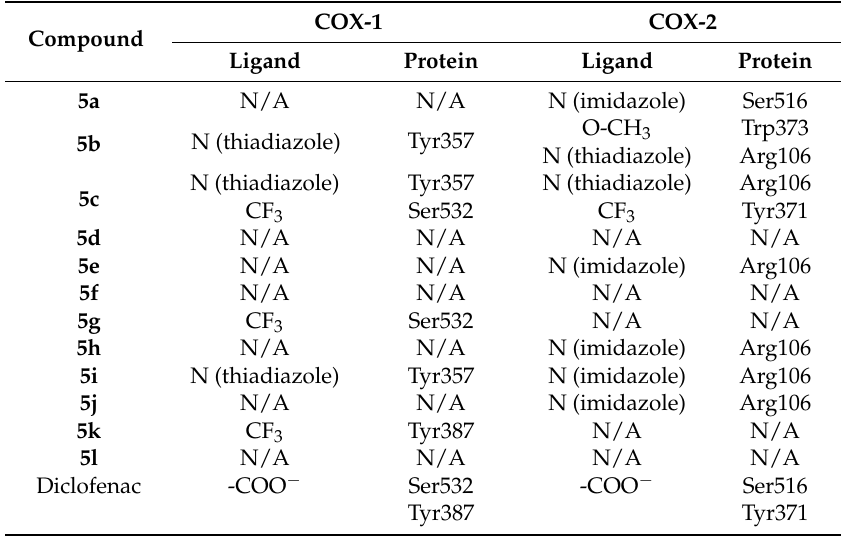
Table 6. The hydrogen bonds predicted to take place between compounds 5a – l and COX-1 and COX-2